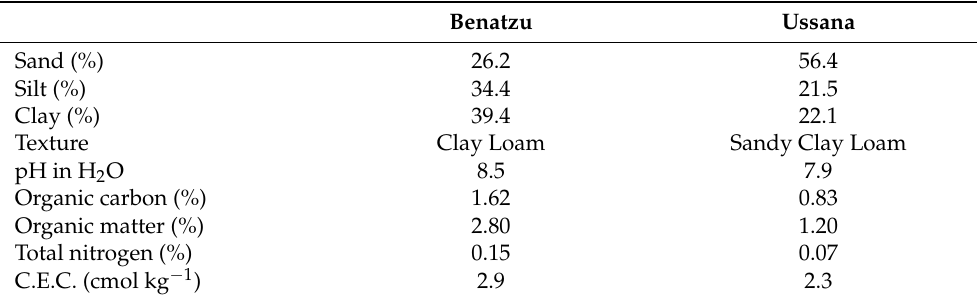
Table 1. Physical and chemical characteristics of soil at Benatzu and Ussana experimental